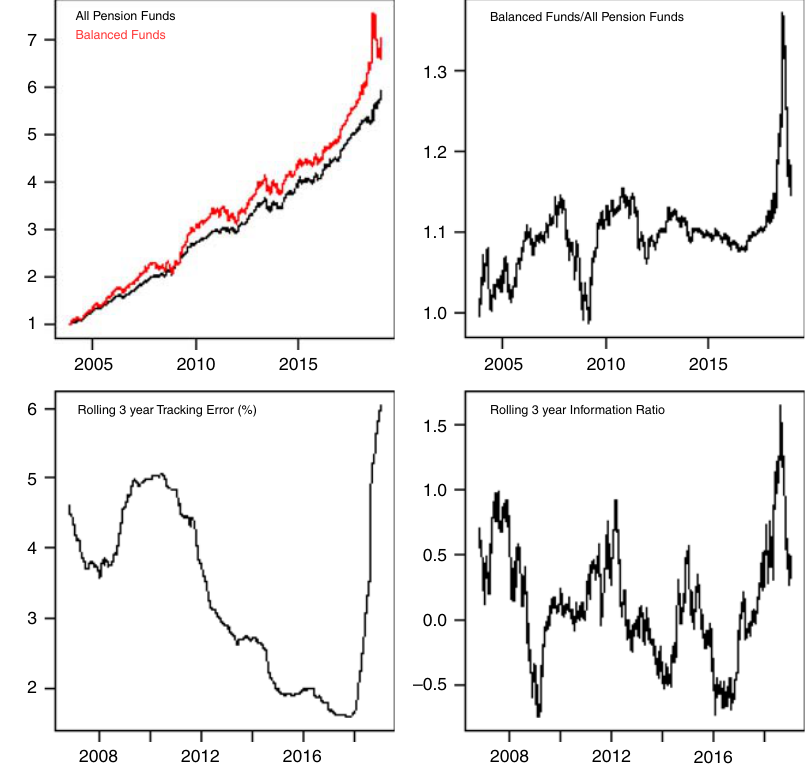
Figure 5. Performance of balanced